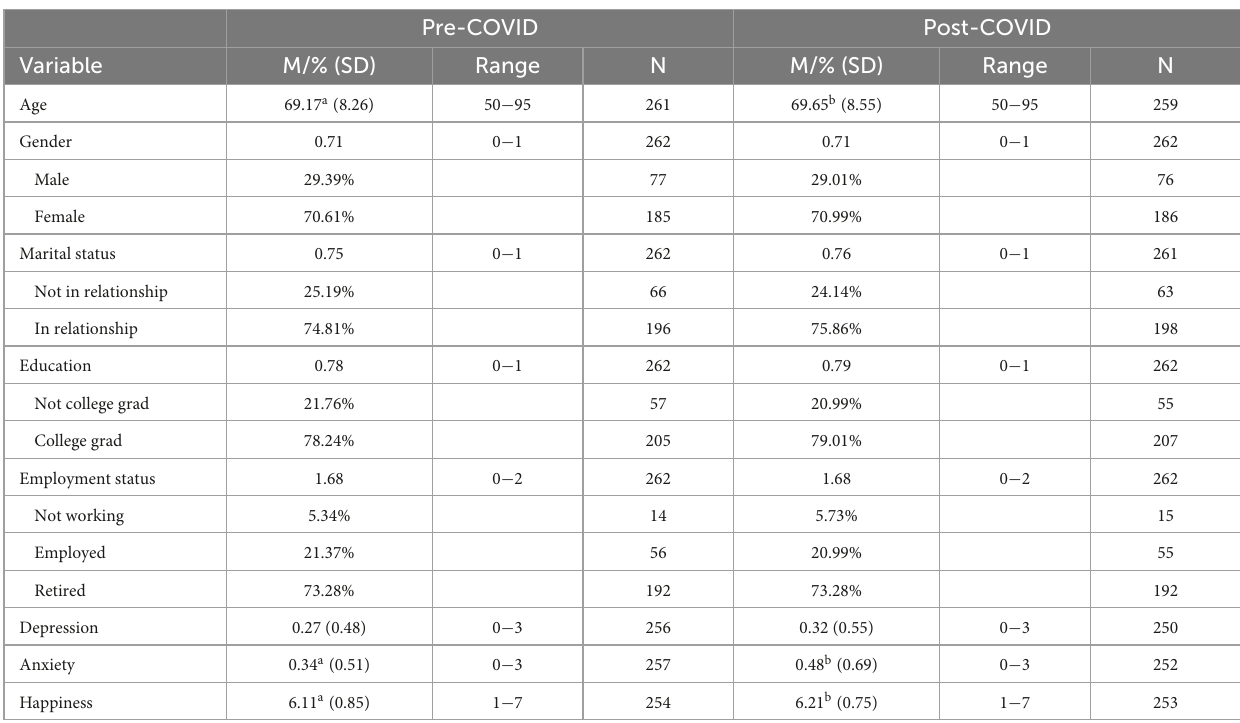
TABLE 4 Descriptive statistics for study 2 ( N =